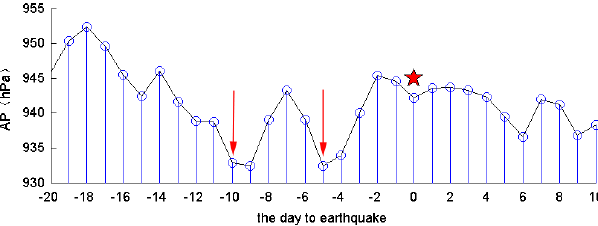
Fig. 8. Air pressure variation at the point 30 ◦ N, 105 ◦ E before and after the event (red star points to the day in which earthquake hap- pened).